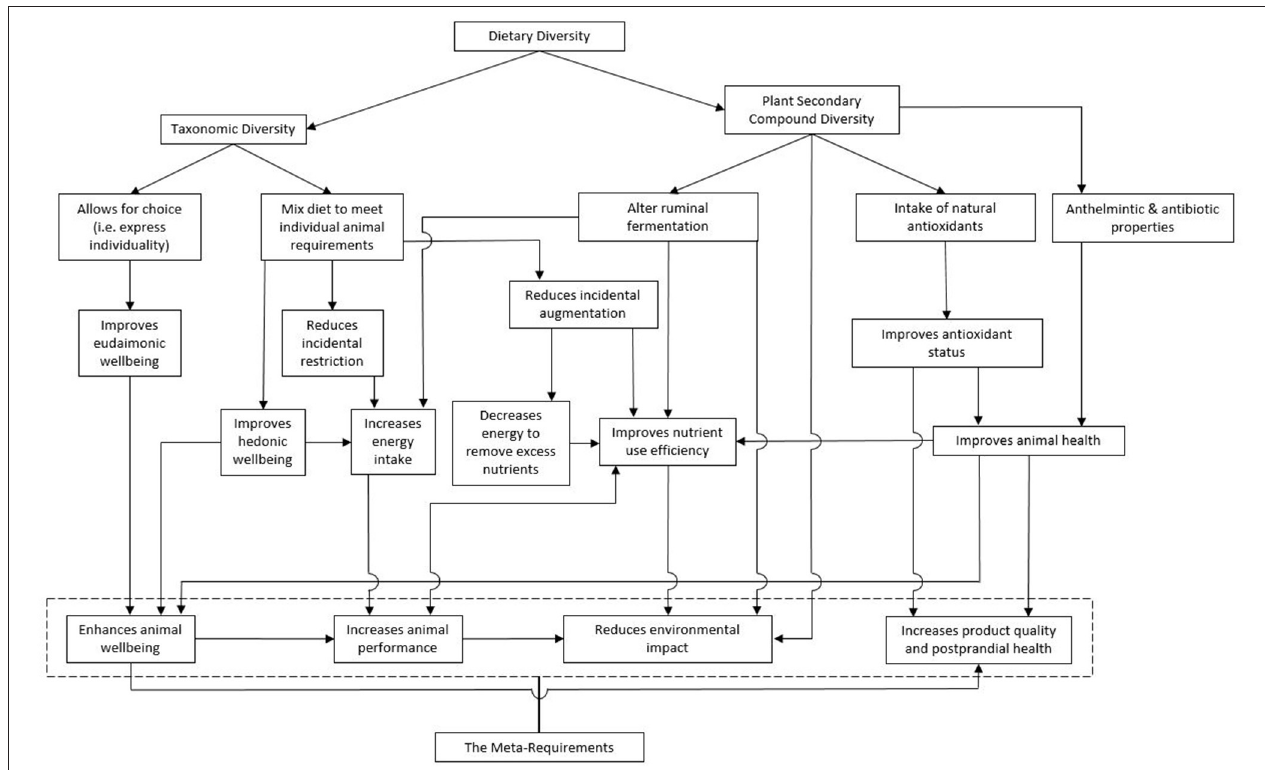
FIGURE 2 | The “Kernel Theories” behind how FDD (i.e., the meta-design) can be implemented to meet our